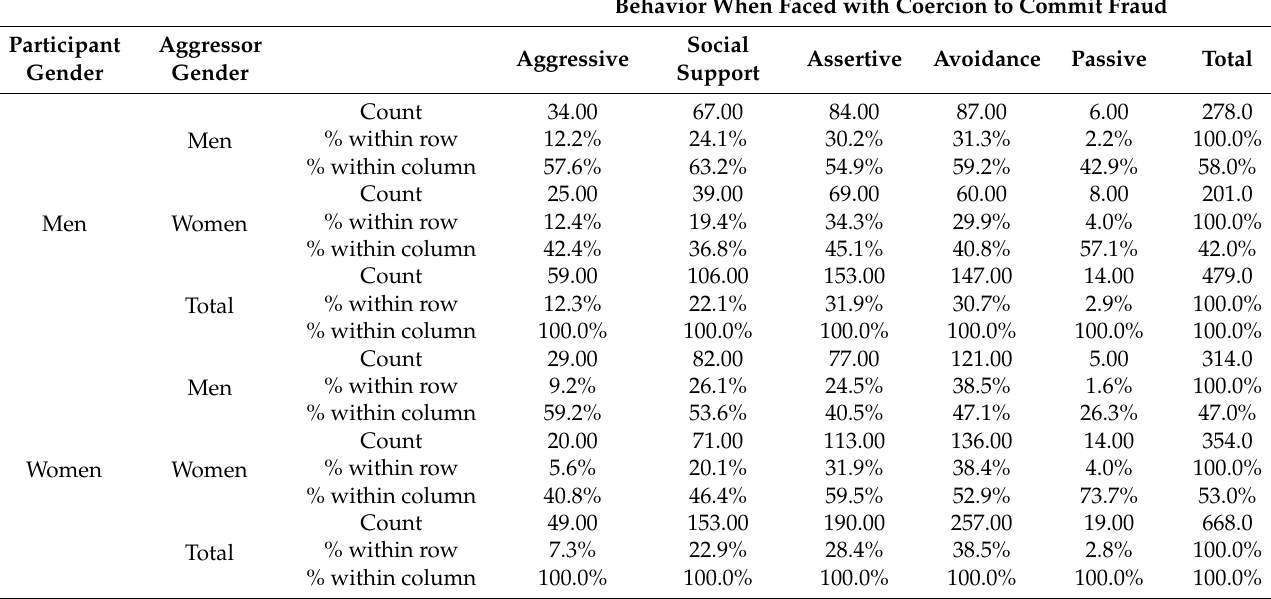
Table 2. Gender differences in the participant’s and aggressor’s behavior when faced with coercion to commit fraud. Behavior When Faced with Coercion to Commit